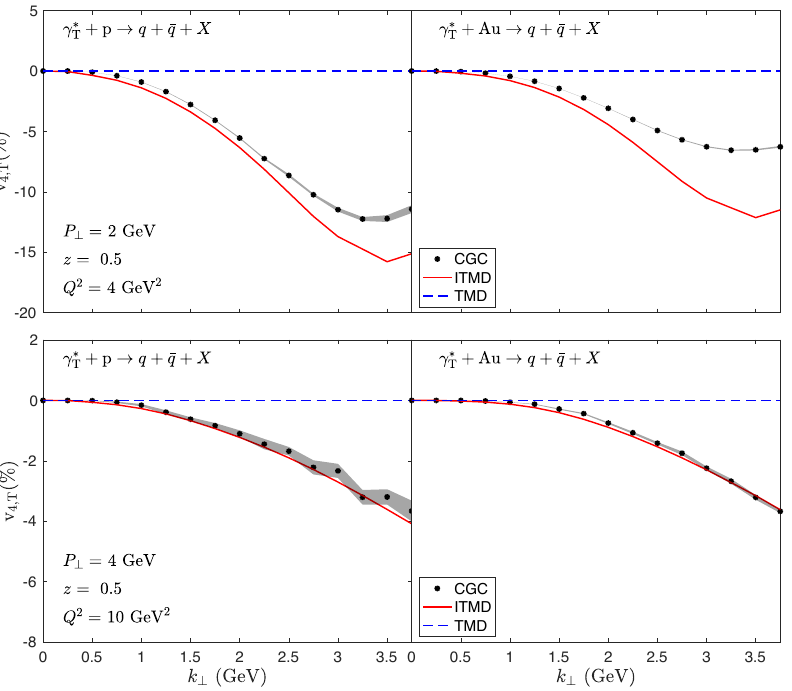
Figure 12 . Quadrangular anisotropy v 4 in the angle φ for production of quark anti-quark pairs in γ ∗ + p (left) and γ ∗ + Au (right) scattering. The grey band shows the numerical uncertainty of the T T CGC